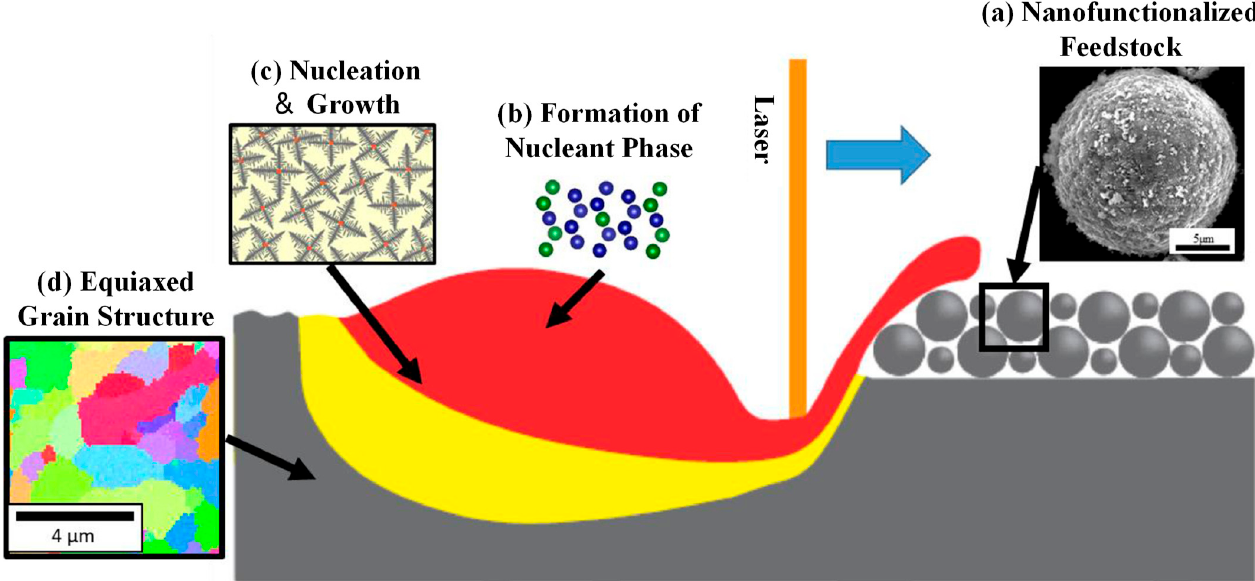
Figure 3. Process of laser-based additive manufacturing with nanoparticles and metal powders. Laser scan left to right, ( a ) nanoparticles and metal powders, ( b ) formation of nucleate in the melt, ( c ) promoting heterogeneous nucleating, and ( d ) leading to an equiaxed final microstructure in the printed part, reprinted with permission from ref. [11], 2022, Elsevier.